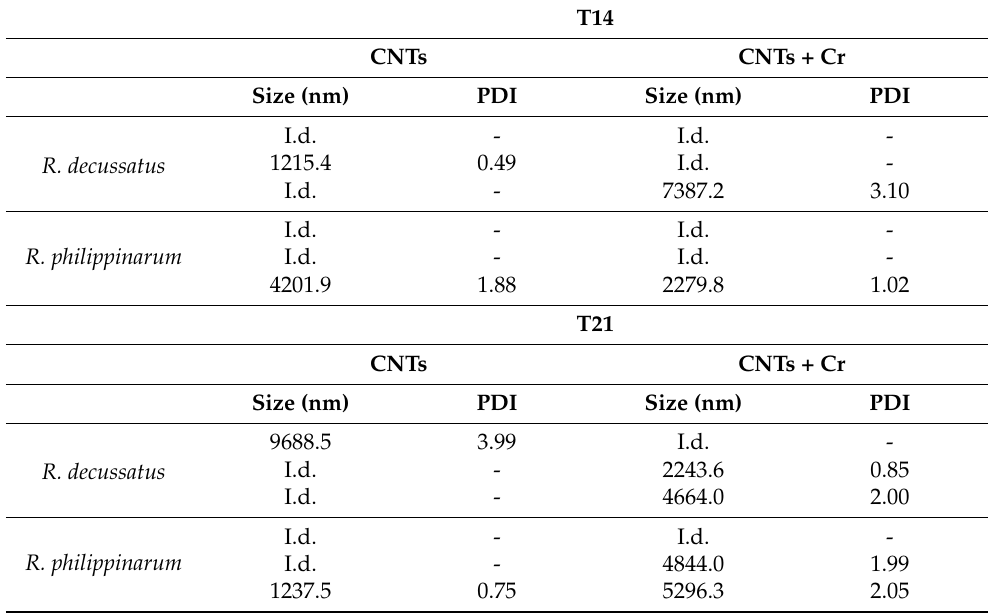
Table 1. Dynamic light scattering (DLS) results of size (nm) and polydispersity index (PDI) of carbon nanotubes (CNTs) alone and in combination with chromium (CNTs+ Cr) suspensions collected along different exposure times (days 7 (T7), 14 (T14), 21 (T21), and 28 (T28)) and tests ( Ruditapes decussatus and Ruditapes philippinarum ). I.d.: not detected colloidal material in the analyzed sample at the end of 120